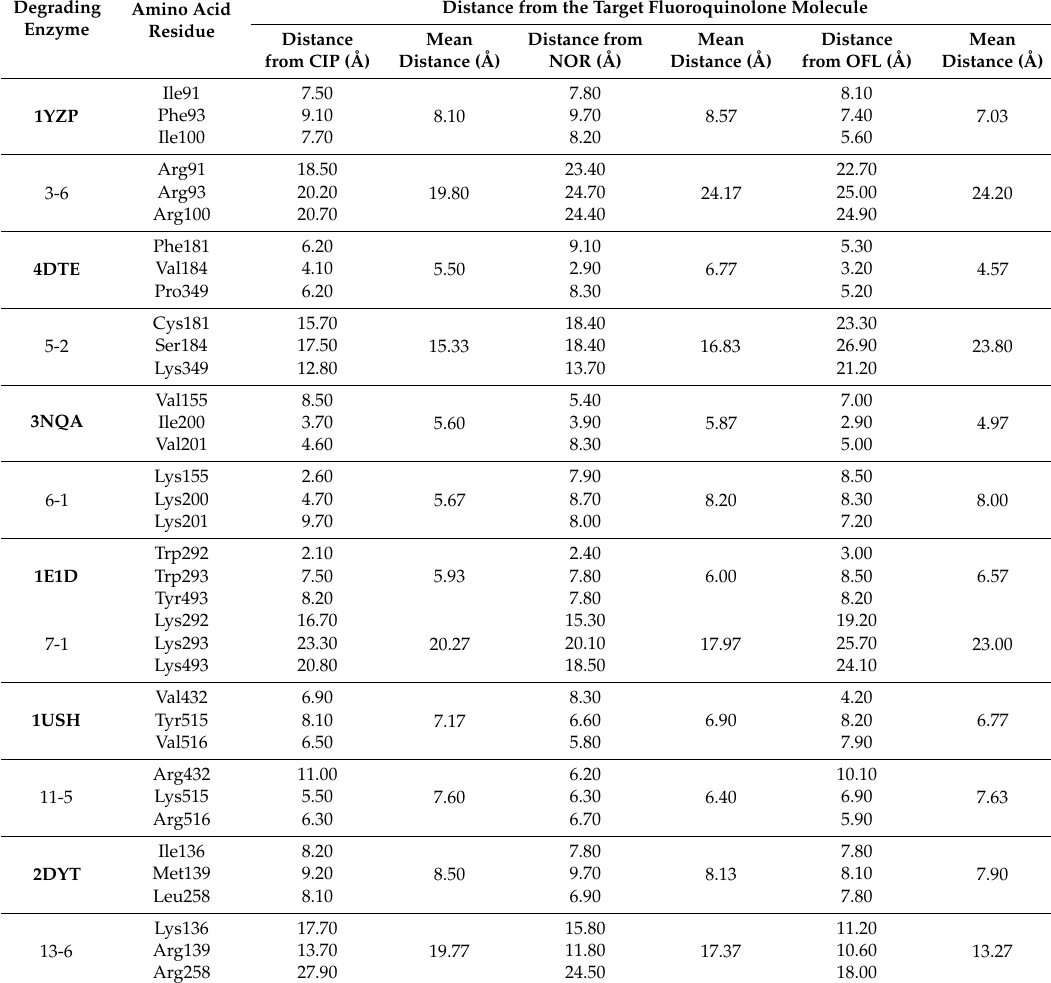
Table 8. The distance between the amino acid residue of the degrading enzyme and the target fluoroquinolone molecule before and after